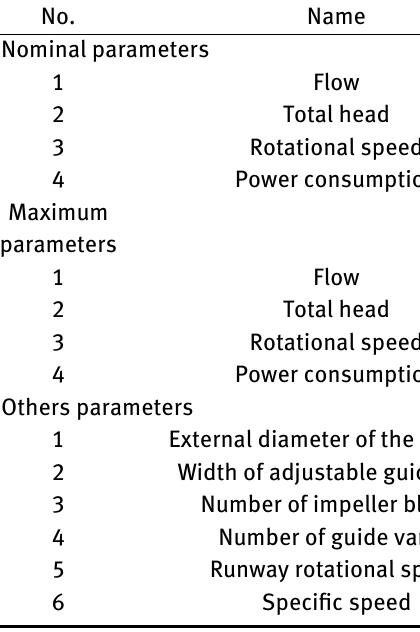
Table 1: Operating and geometrical parameters of the analyzed water turbine No. Nominal